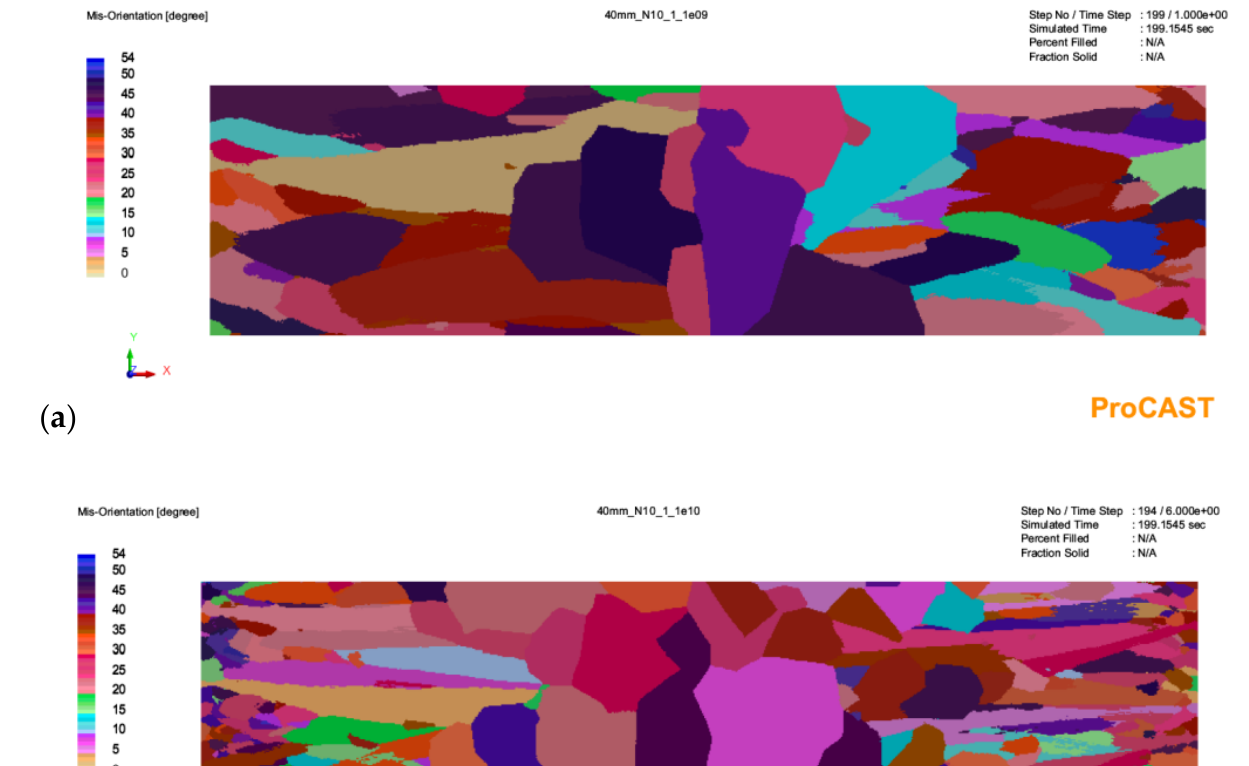
Figure 4. Simulation results for a casting wall thickness of 30 mm with a given number of austenite nucleation sites in the amount of: ( a )—10 9 ; ( b )—10 10 ; ( c )—10 11 .